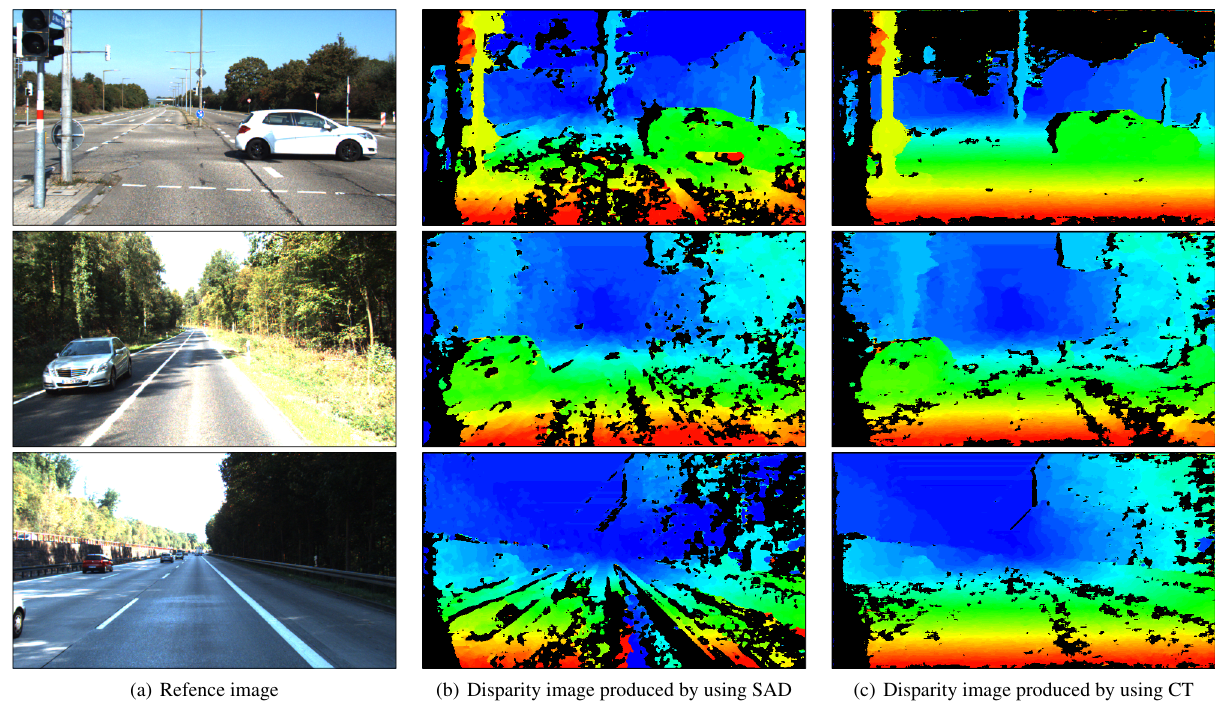
Figure 6. Qualitative results achieved by our algorithm for disparity estimation on the KITTI Stereo 2015 Benchmark (Menze and Geiger, 2015). The disparity is colour coded, going from red (large disparity, near) to blue (small disparity, far). The black areas correspond to undefined disparity areas.